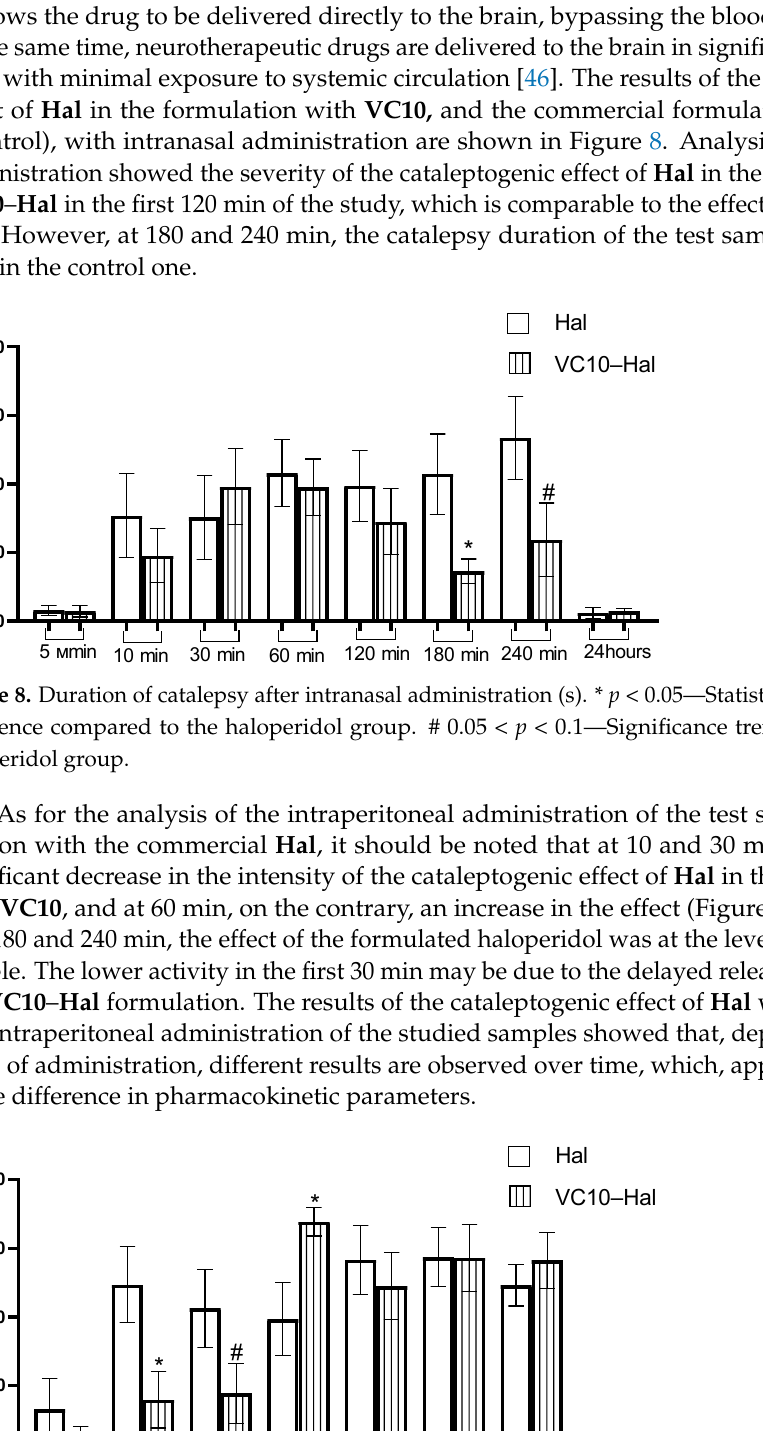
Figure 9. Duration of catalepsy after intraperitoneal administration (s). * p < 0.05—Statistically significant difference compared to the haloperidol group. # 0.05 < p < 0.1—Significance trend compared to haloperidol group.